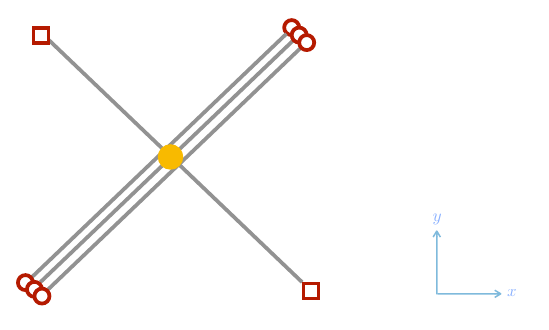
Figure 7 . X 1 ,N fixed point ( N = 3 in the figure).